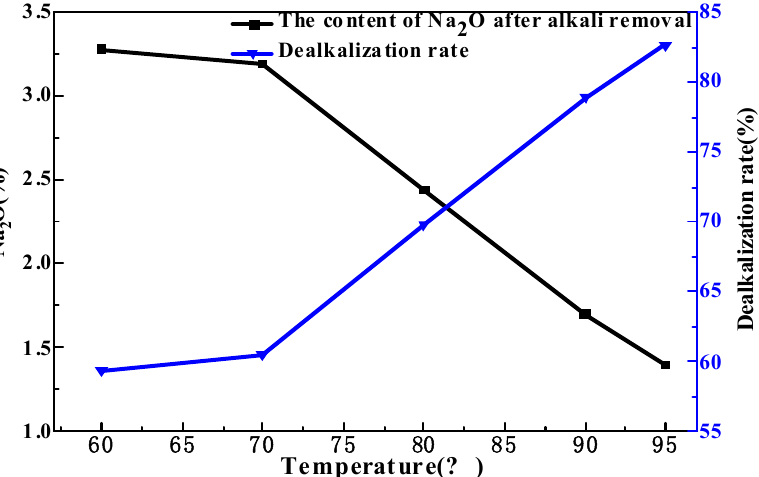
Figure 10. Effect of reaction temperature on dealkalization rate.